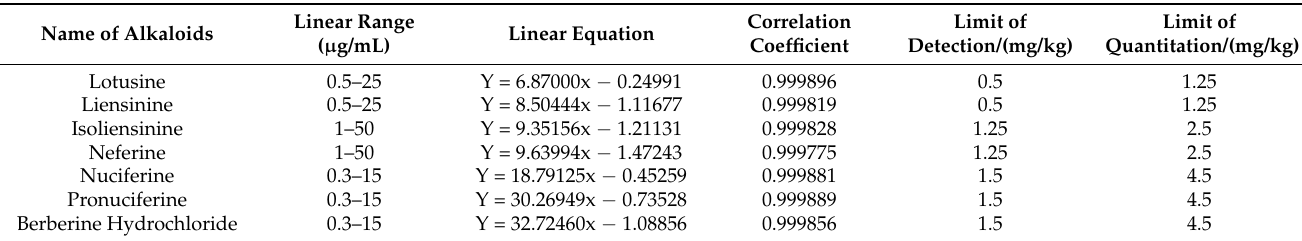
Table 4. Linear range, linear equation, correlation coefficient, limit of detection and limit of quantita- tion of seven kinds of alkaloids.